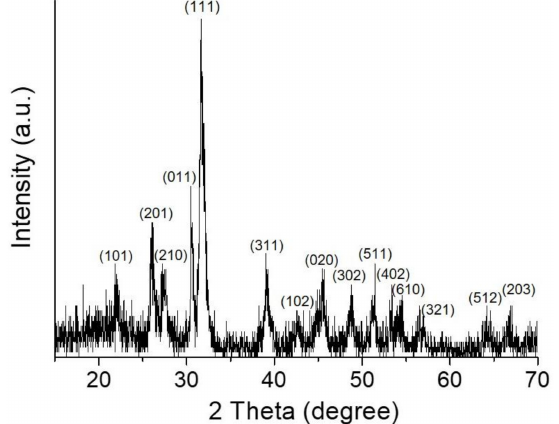
Figure 7. XRD results of the RGO/F-SnS NCs synthesized in this